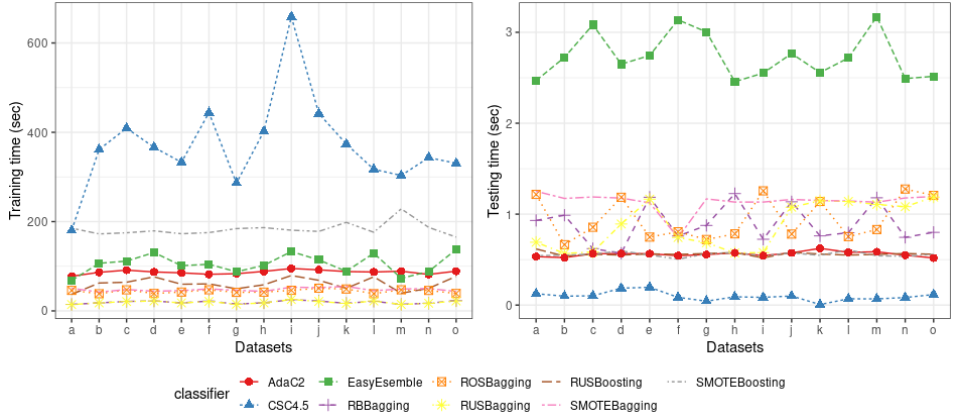
Figure 4. Comparison of the average performance values such as balanced accuracy ( a ), kappa ( b ), and AUC ( c ), across all datasets attained by all classifiers using the Nemenyi critical difference plot.